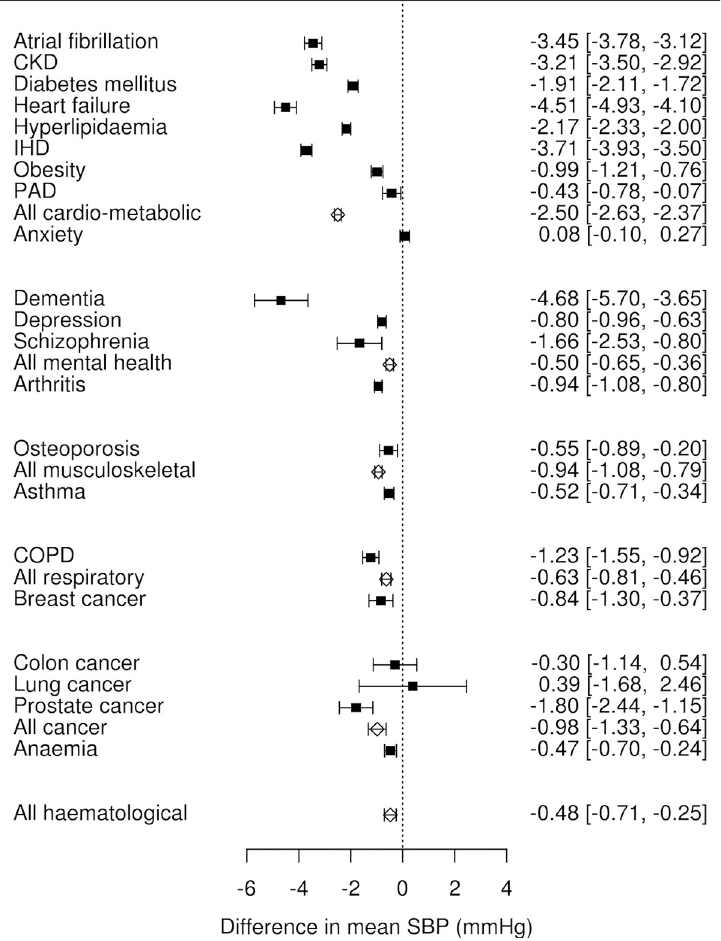
Fig 3. Adjusted mean differences in SBP at 1 year after hypertension diagnosis stratified by comorbidity status. All models were adjusted for age, sex, deprivation level, ethnicity, cholesterol, BMI, smoking status, number of classes of prescribed antihypertensive medications, and year of diagnosis of hypertension. Reference group for each point estimate was patients without that particular comorbidity. BMI, body mass index; CKD, chronic kidney disease; COPD, chronic obstructive pulmonary disease; IHD, ischaemic heart disease; PAD, peripheral arterial disease; SBP, systolic blood pressure; TIA, transient ischaemic